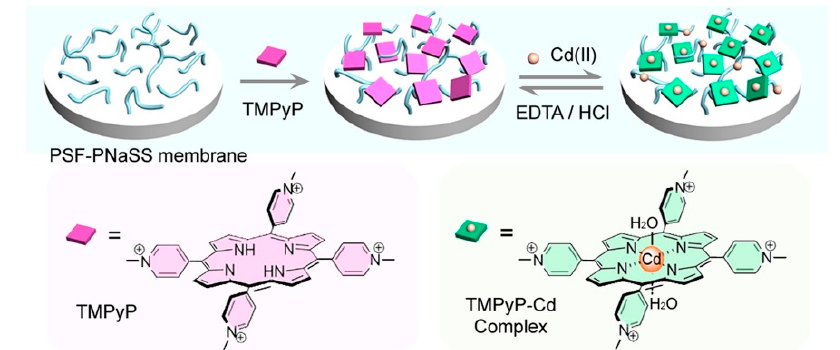
Figure 9. Schematic model of optical sensor membrane fabrication and flow-through detection of Cd 2+ ions. Reprinted with permission from ref [45]. Copyright 2019 Elsevier Ltd. All rights reserved.